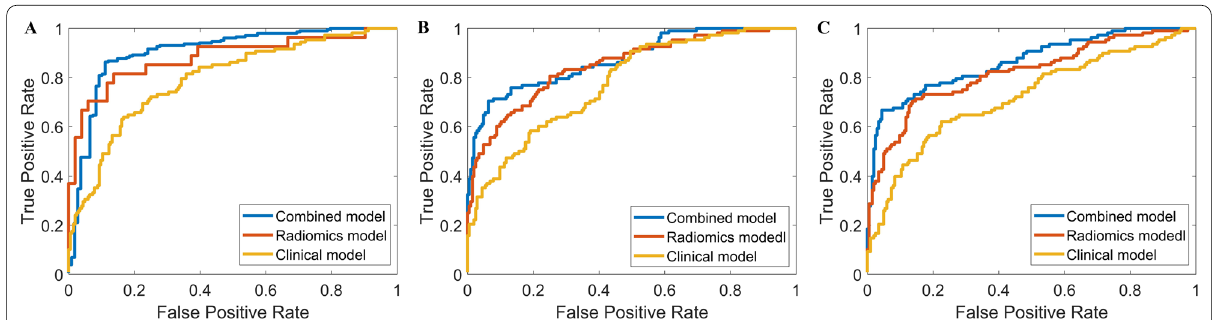
Fig. 5 Predictive performance of SVM-ReliefF classifier in clinicoradiological, radiomics, and combined models. a Receiver operating characteristic (ROC) curve analysis for the training cohort. b ROC curve analysis for the validation cohort. c ROC curve analysis for the testing